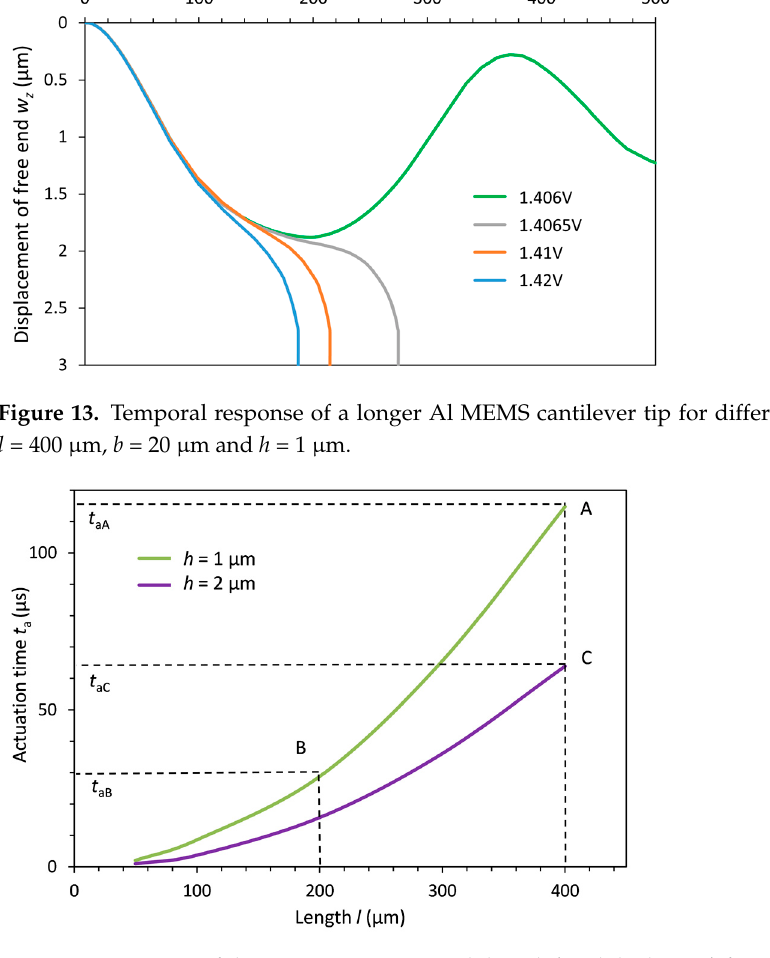
400 μ m, b = 20 μ m and h = 1 μ m.